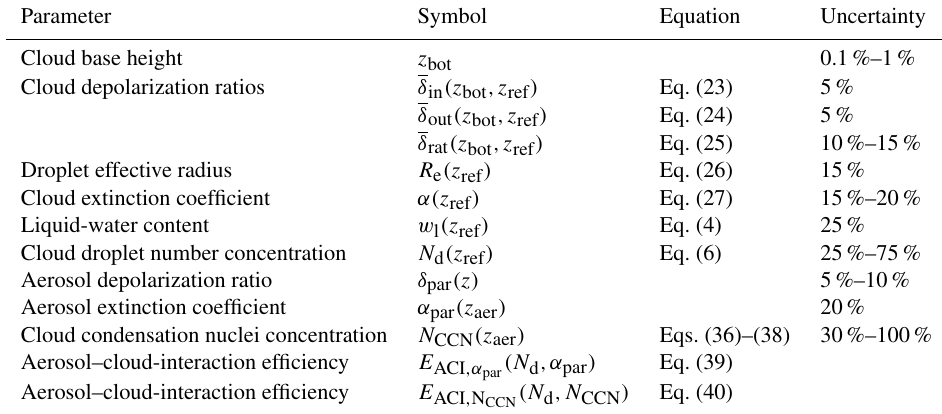
Table 1. Overview of the cloud and aerosol retrieval procedure (step-by-step data analysis). The retrieval procedure starts with the determi- nation of the cloud base height z bot . The cloud depolarization ratios δ in and δ out and the ratio δ rat = δ in /δ out , integrated over the height range from the cloud base at z top to the cloud retrieval or reference height z ref , are calculated from the height profiles of measured volume linear depolarization ratios (see Sect. 3.2). The cloud products R e , α , w l , and N d are given for the reference height z ref , 75m above the cloud base height z bot . The computation of the aerosol–cloud-interaction (ACI) efficiencies E ACI is based on N d , particle extinction coefficient α par , and CCN concentration N CCN at z aer , usually several hundreds of meters below the cloud base. The aerosol proxies are determined from aerosol measurements with the same dual-FOV lidar. All equations refer to Part 1 (Jimenez et al., 2020). Parameter Symbol Equation